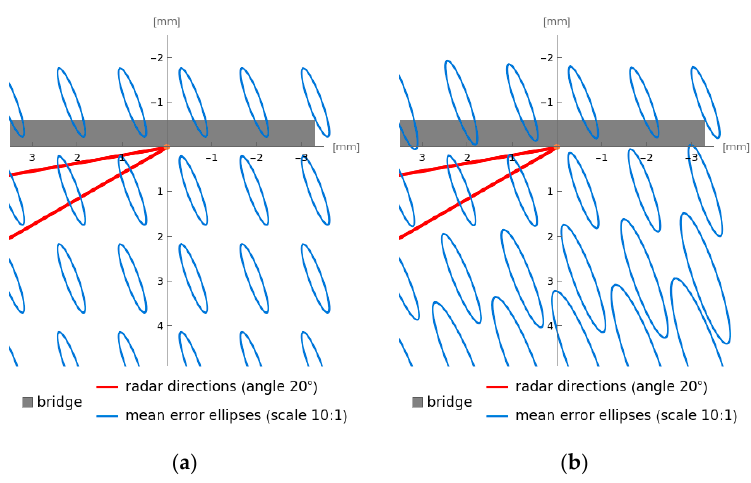
Figure 6. Accuracy of displacement vector [𝑠 (cid:3025) , 𝑠 (cid:3026) ] when radars are located behind each other, and vertical angles of radar directions are 10 ∘ and 30 ∘ : Standard deviation of measured LOS displace- ments is 0.02 mm. Scale of the mean error ellipses is 10:1. ( a ) Imprecision of the vertical angles of radar directions was neglected; ( b ) precision of the vertical angles is given by means of standard deviation 0.5 ∘ .